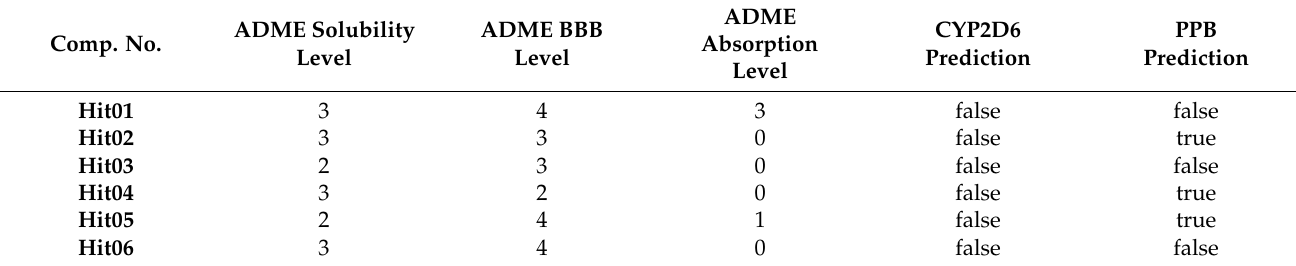
Table 4. ADMET descriptors of the selected